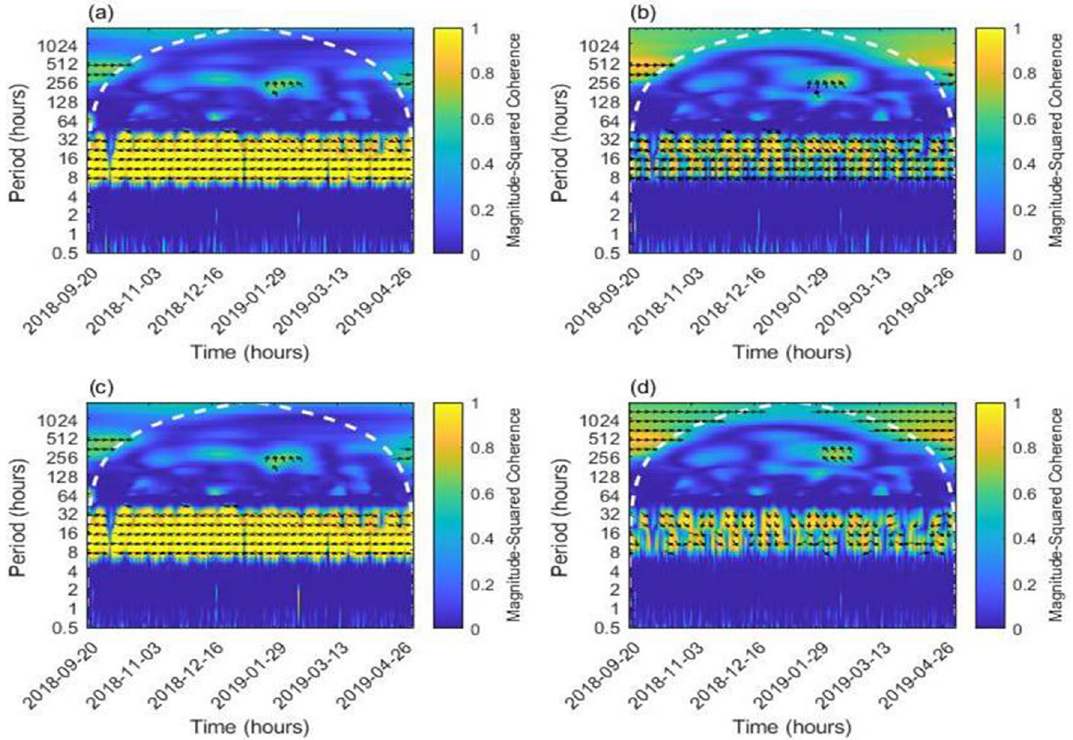
Figure 8. Wavelet coherence between the Earth tide and detrended PX-1 water level ( a ); detrended PX-2 water level ( b ); detrended and denoised PX-1 water level ( c ); and detrended and denoised PX-2 water level ( d ). Possibly distorted areas are divided with white dotted lines.